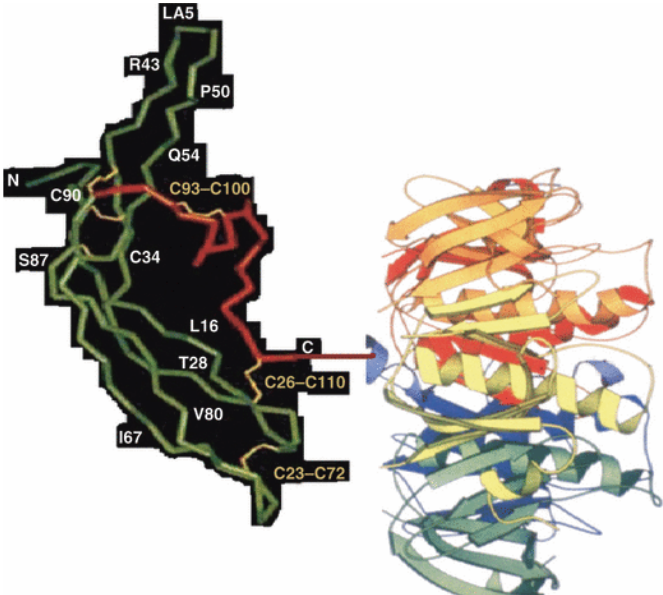
Figure 2. Recombinant anti-hCG vaccine hCGβ-LTB. The carrier LTB is linked at the C-terminal amino acid glutamine of hCGβ. Reproduced from [6]